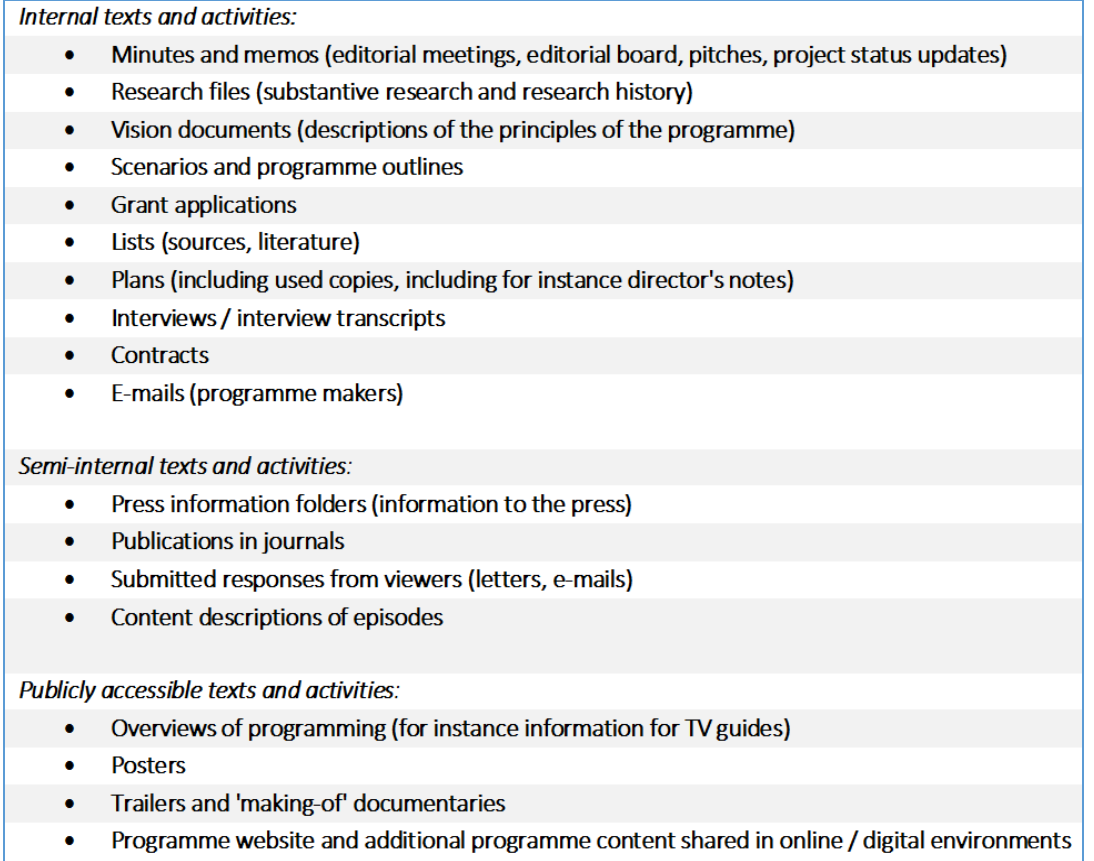
Figure 6. Examples of production documents for archive-based history programmes: internal, semi-internal and publicly accessible texts and activities